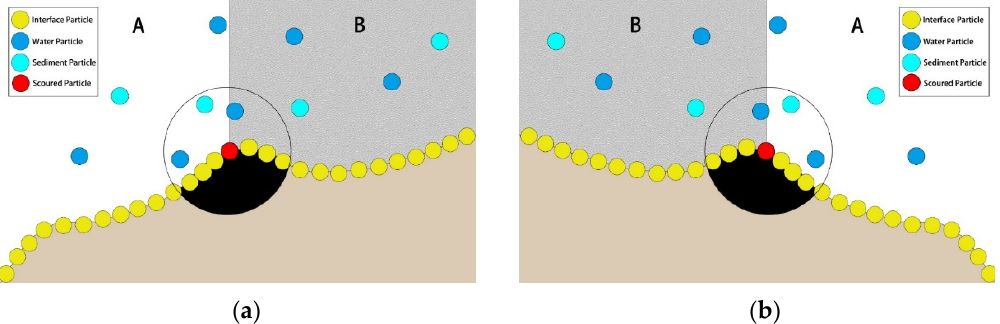
Figure 5. Particle initiation process on different slopes. ( a ) refers to the section upstream the dam body; ( b ) refers to the section downstream the dam body.